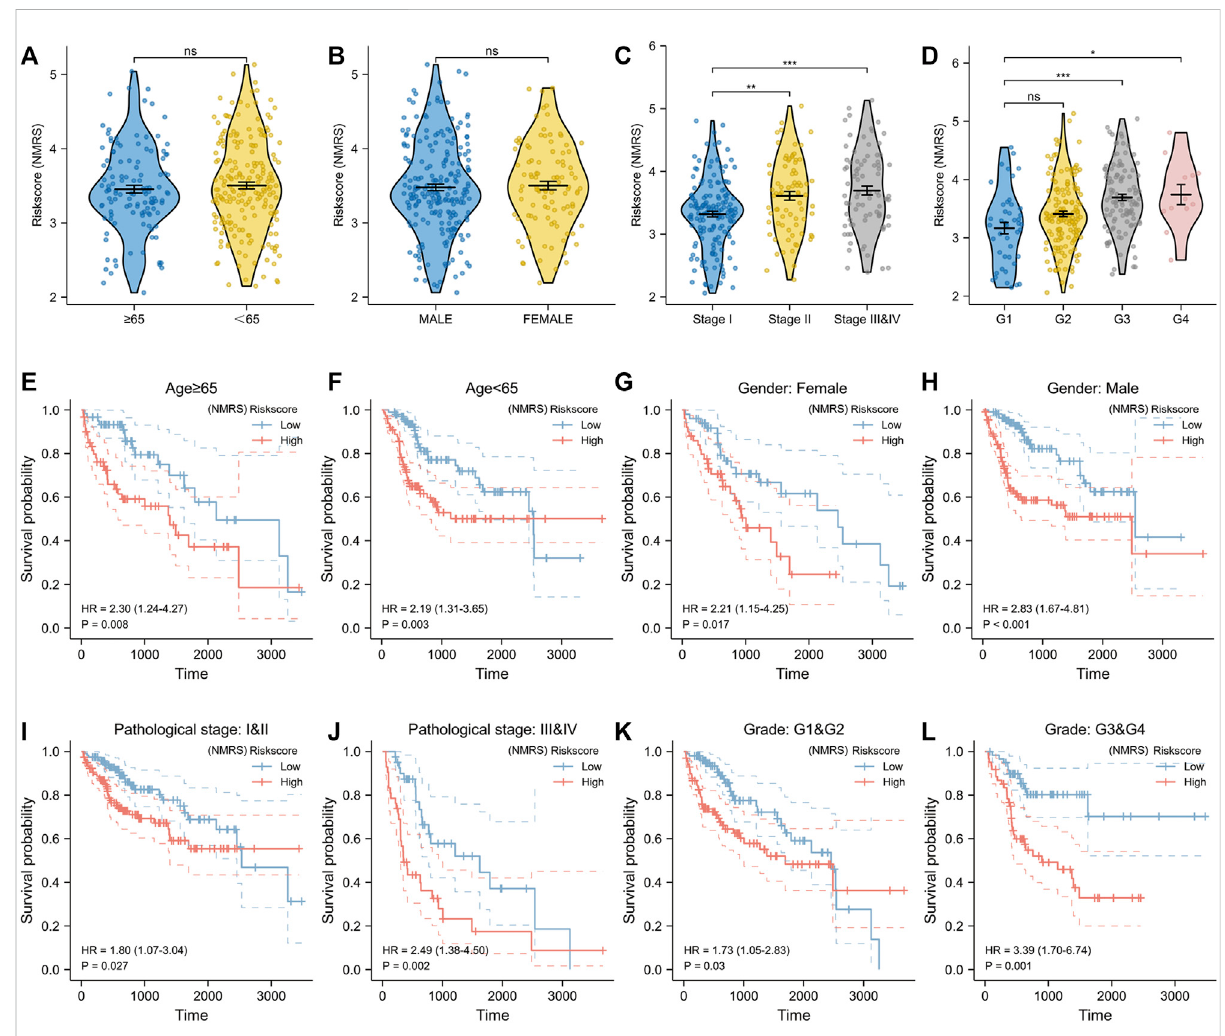
FIGURE 3 Correlation of NMRS with clinical factors. (A) There was no statistical difference in NMRS between hepatocellular carcinoma patients with age ≥ 65 and those with age < 65. (B) There was no statistical difference in NMRS between male patients and female patients. (C) Patients with pathologic stage II or pathologic stage III and IV had higher NMRS compared with patients with pathologic stage (I) (D) Patients with Grade G3 & G4 had a higher NMRS. (E,F) Kaplan-Meier curves for hepatocellular carcinoma patients aged ≥ 65 and those aged < 65. (G,H) Kaplan-Meier curves of male patients and female patients. (I,J) Kaplan-Meier curves of patients with different pathological stages. (K,L) Kaplan-Meier curves of patients with different